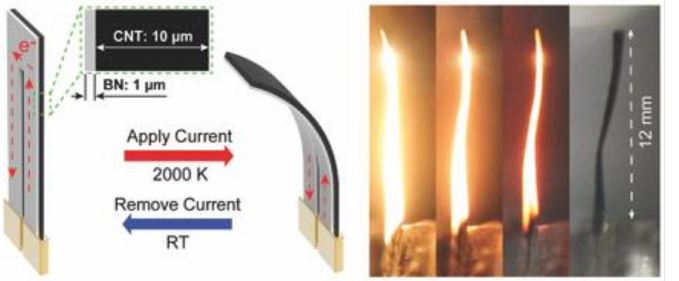
Figure 9. Electromechanical deformation of the actuators upon applying bias voltage under inert atmosphere [249]. Copyright Wiley